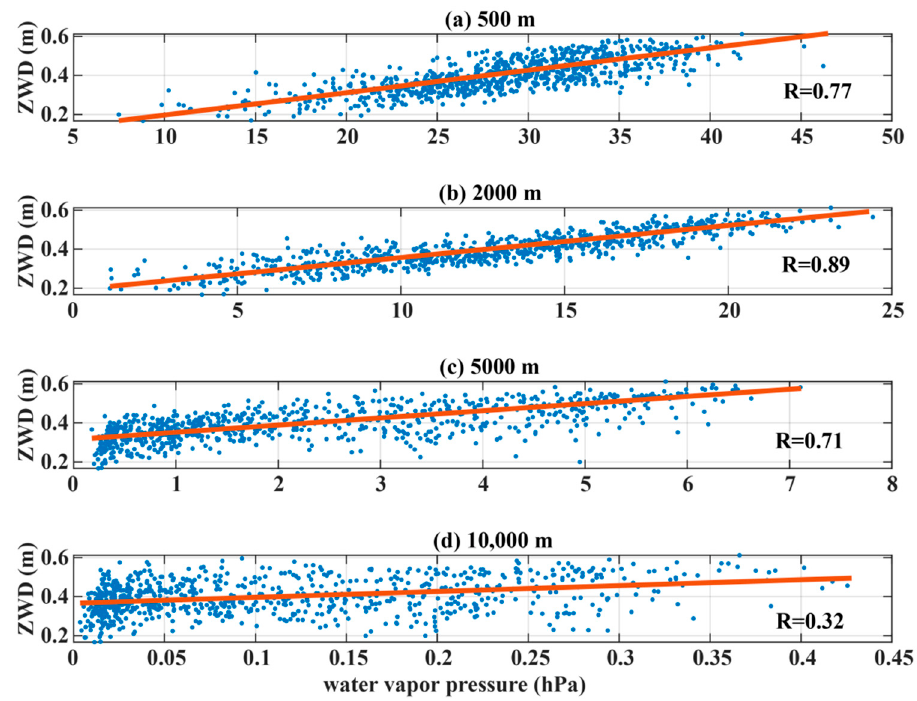
Figure 2. Statistical relationships between zenith wet delay and water vapor pressure at the height of ( a ) 500, ( b ) 2000, ( c ) 5000, and ( d ) 10,000 m, respectively.